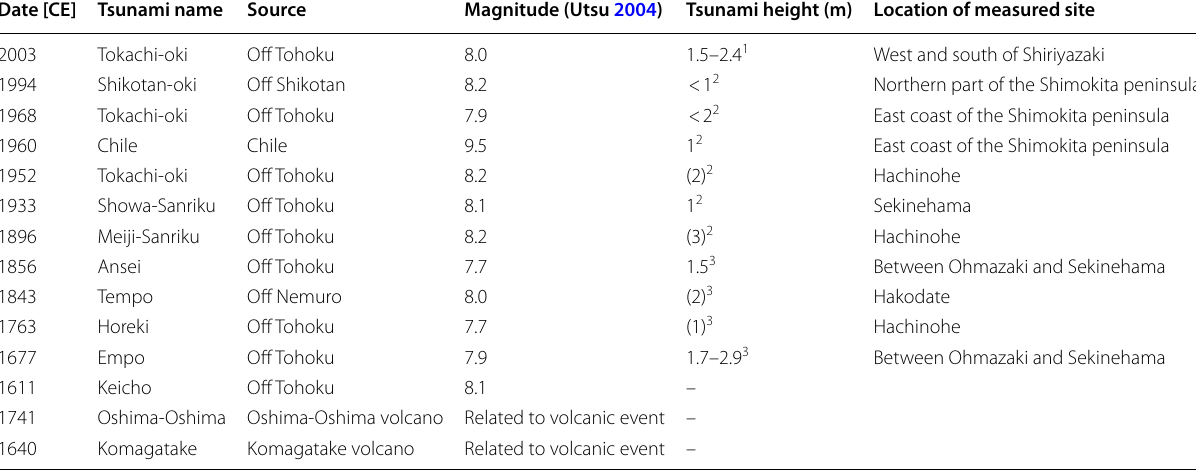
1: Tanioka et al. (2004); 2: Watanabe (1998); and 3: Tsuji et al. (2014) The numbers in parentheses in “Tsunami height” column indicate the values at sites away from